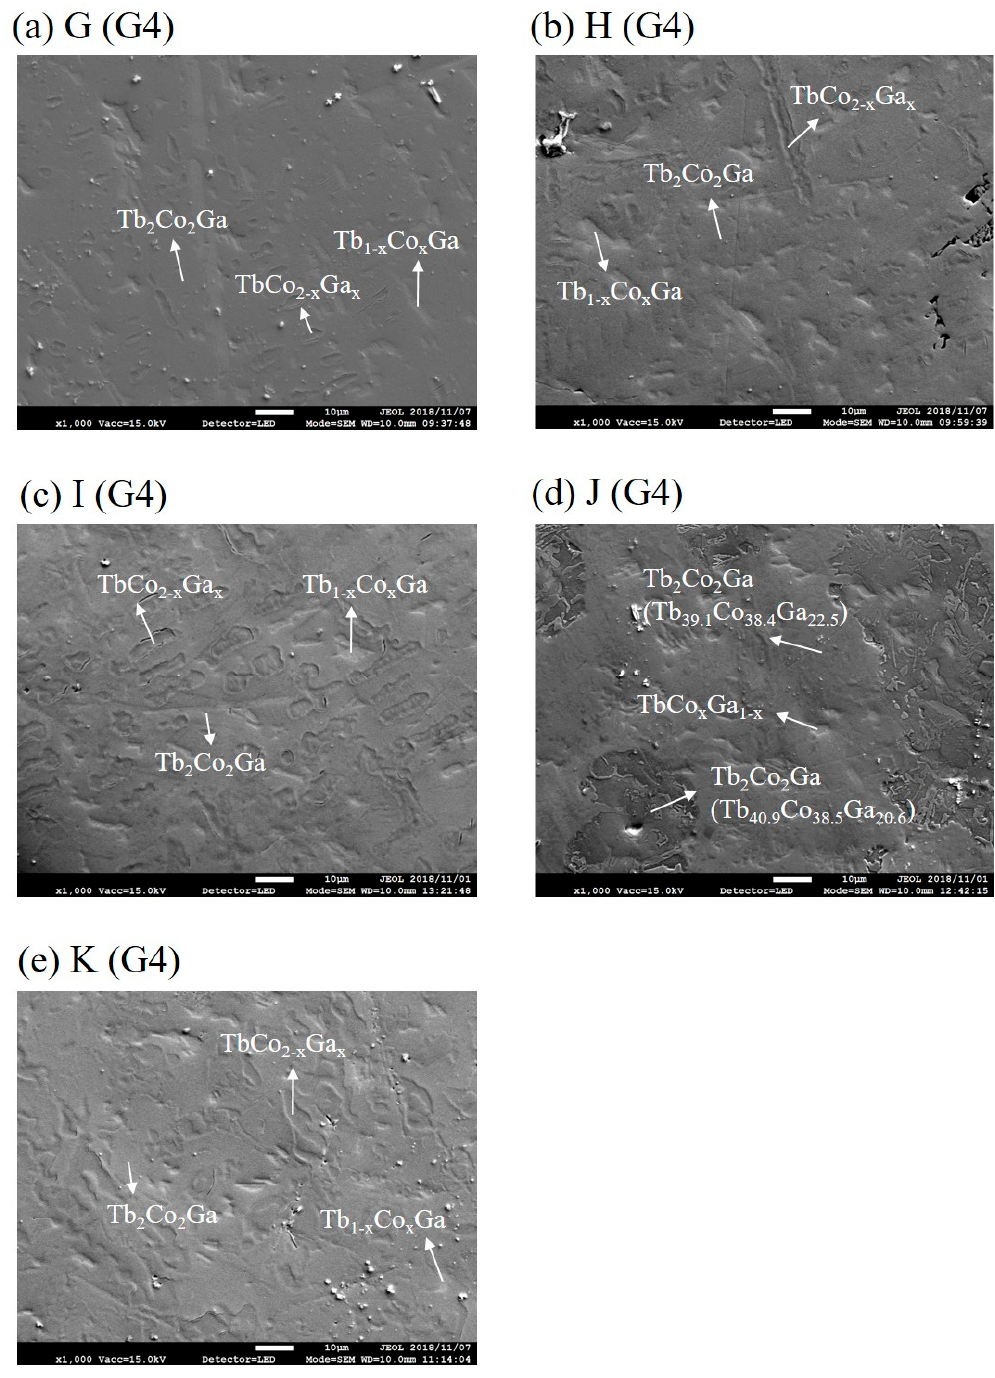
Figure5. Back-scatteredelectron(15keV)imagesofsamples( a )G,( b )H,( c )I,( d )J,and( e Figure 5. Back-scattered electron (15 keV) images of samples ( a ) G, ( b ) H, ( c ) I, ( d ) J, and ( e ) K, respectively.